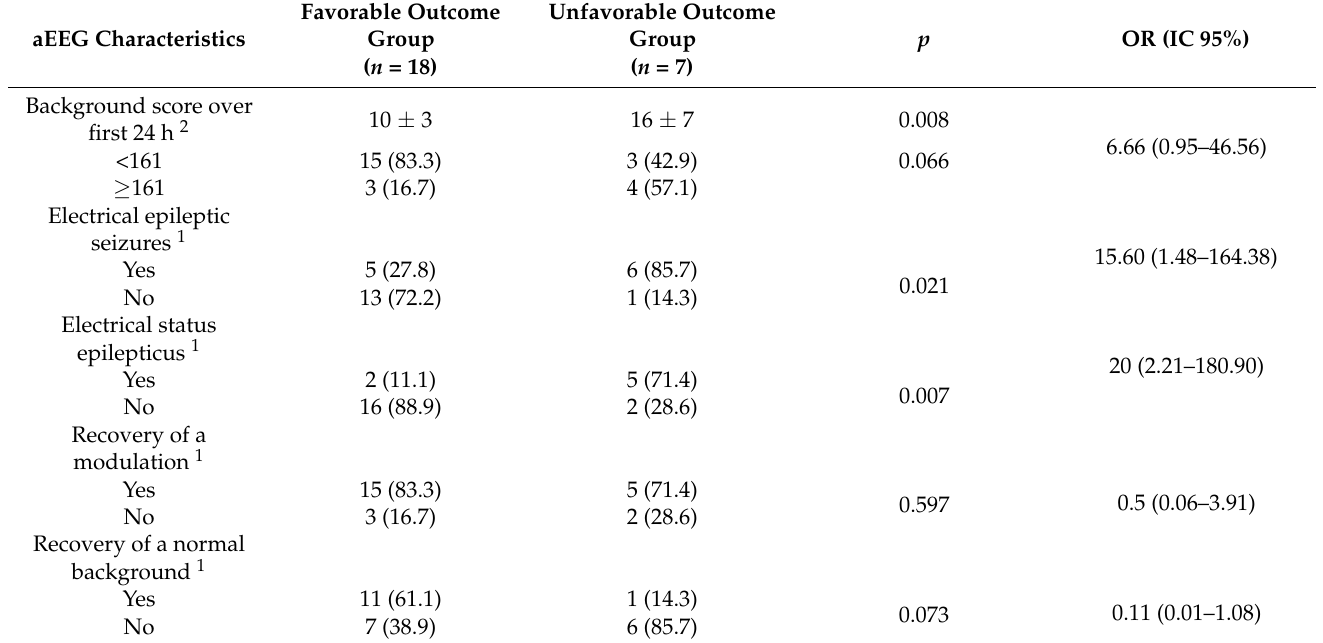
Table 3. Prognostic value of aEEG features during recording.